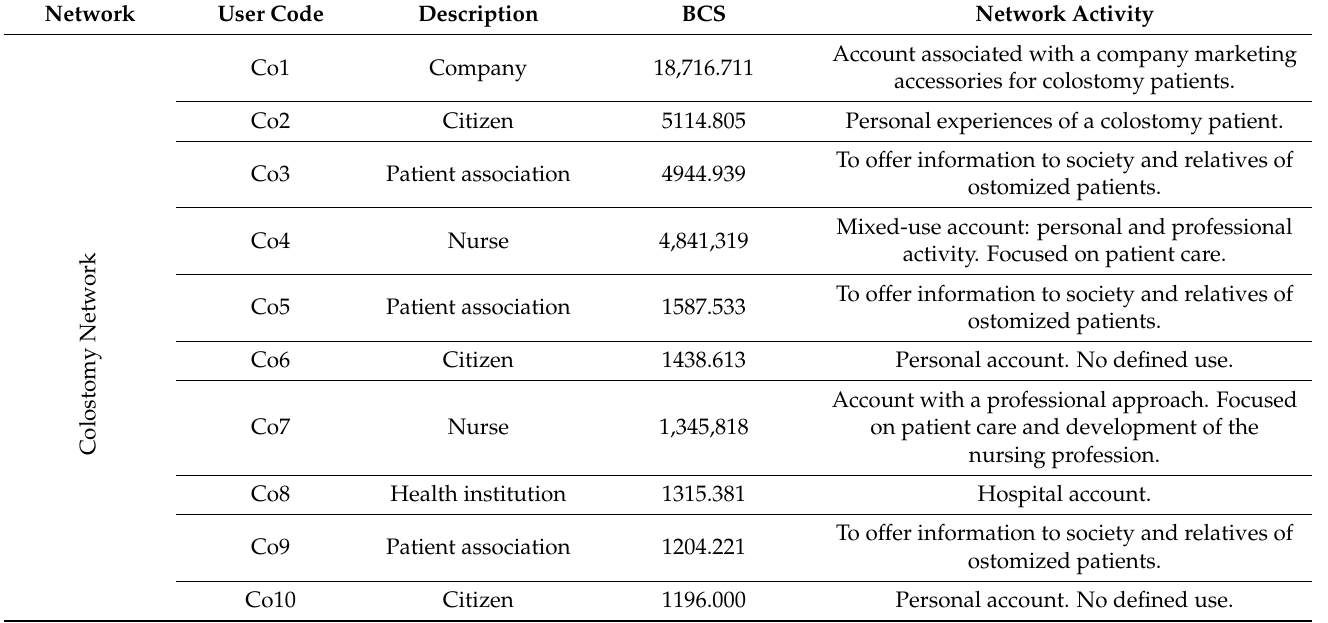
Table 2. Characteristics of most influential users in the “colostomy” network.